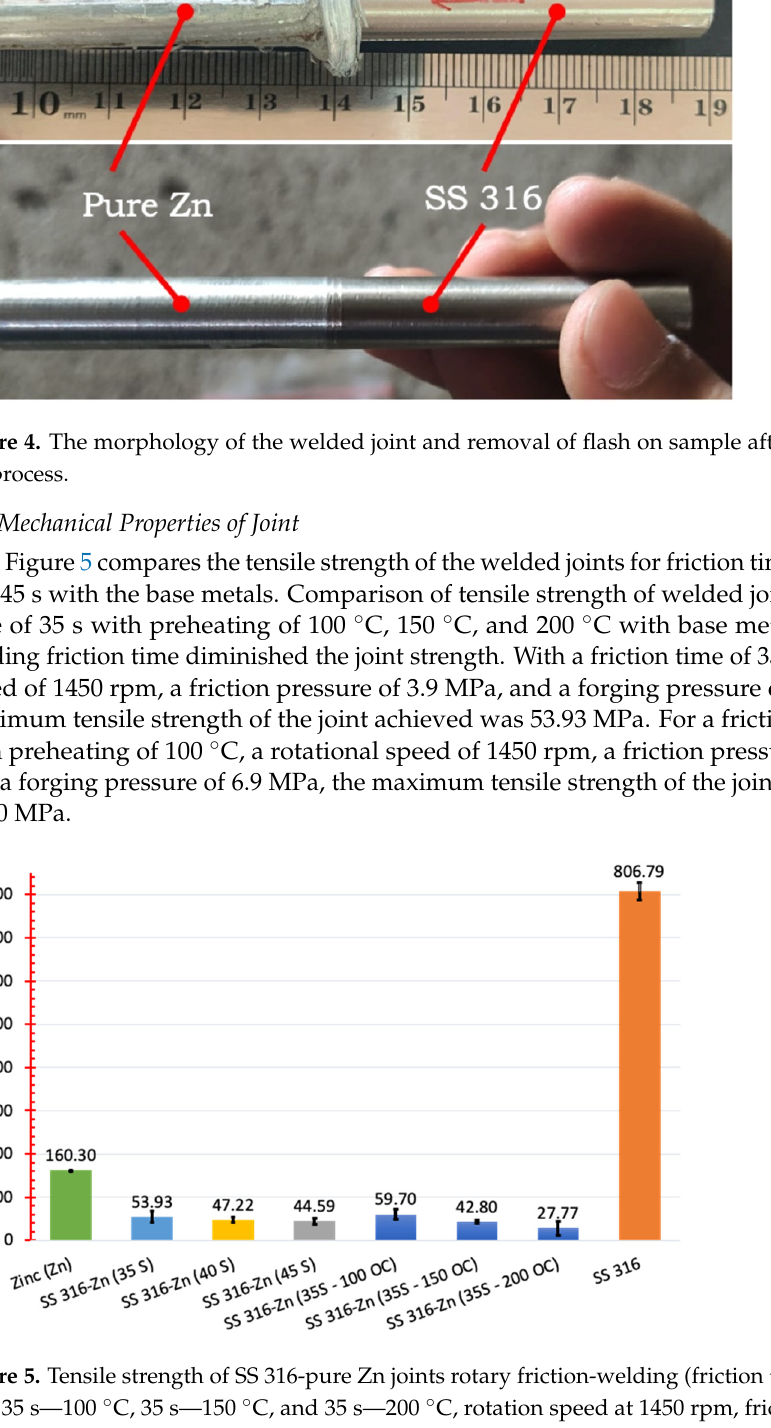
Figure 4. The morphology of the welded joint and removal of flash on sample after friction welding process.